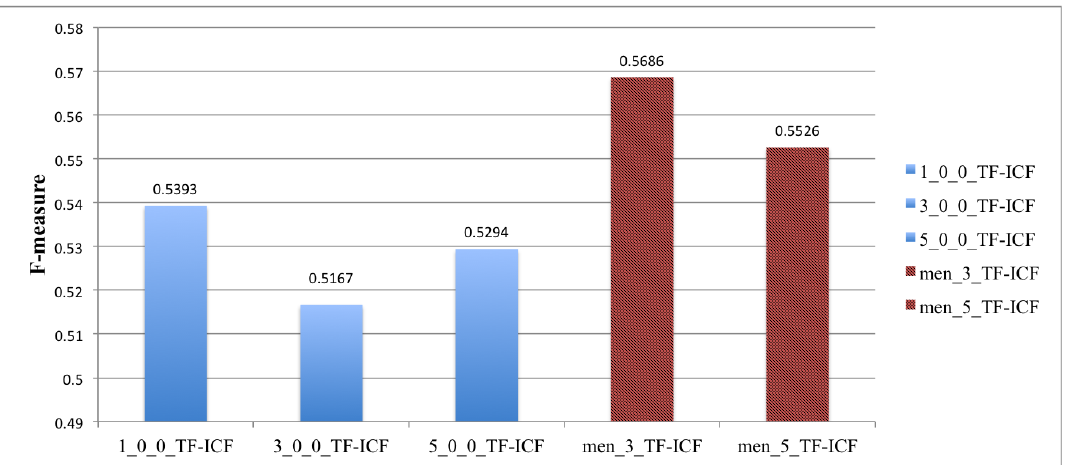
Figure 1. The value of the F-measure in the cross-validation with the training collection for every vocabulary with TF-ICF measured